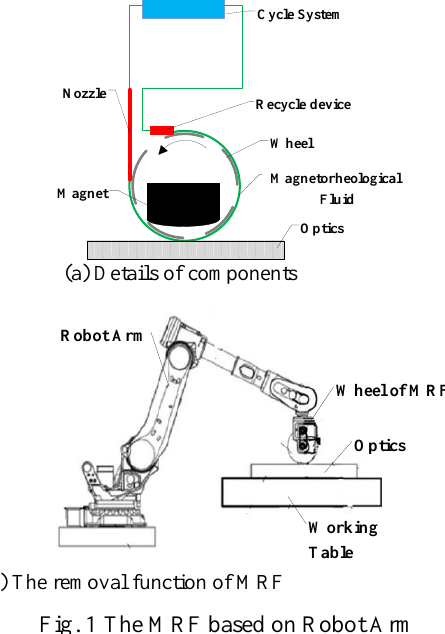
(b) The removal function of MRF Fig. 1 The MRF based on Robot Arm